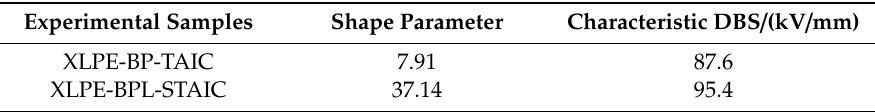
Table 6. The characteristic 63.2% DBS and shape parameter of Weibull distribution fitted in 95% confidence interval for XLPE samples prepared with di ff erent photon initiators and auxiliary